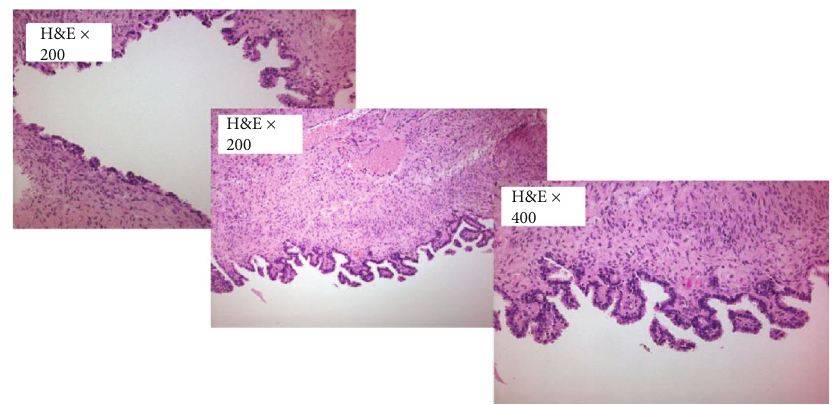
Figure 1: Serous borderline tumor/atypical proliferative serous tumor.